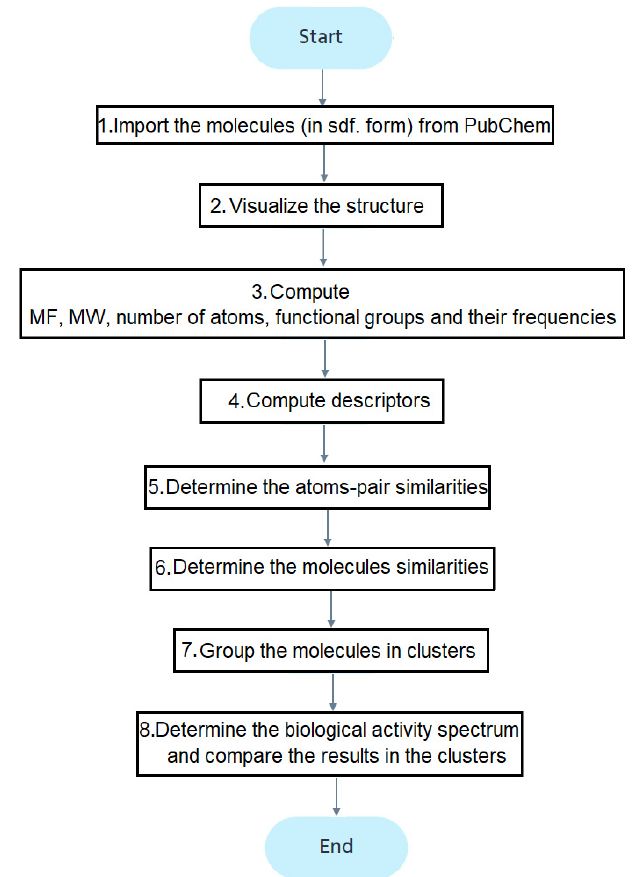
Figure 2. The flowchart of the study.